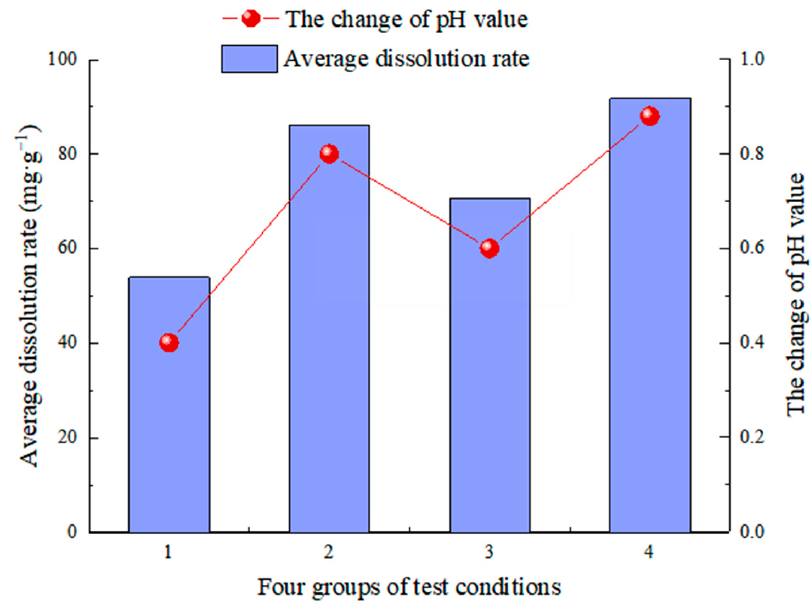
Figure 14. The trend of pH value before and after dissolution.